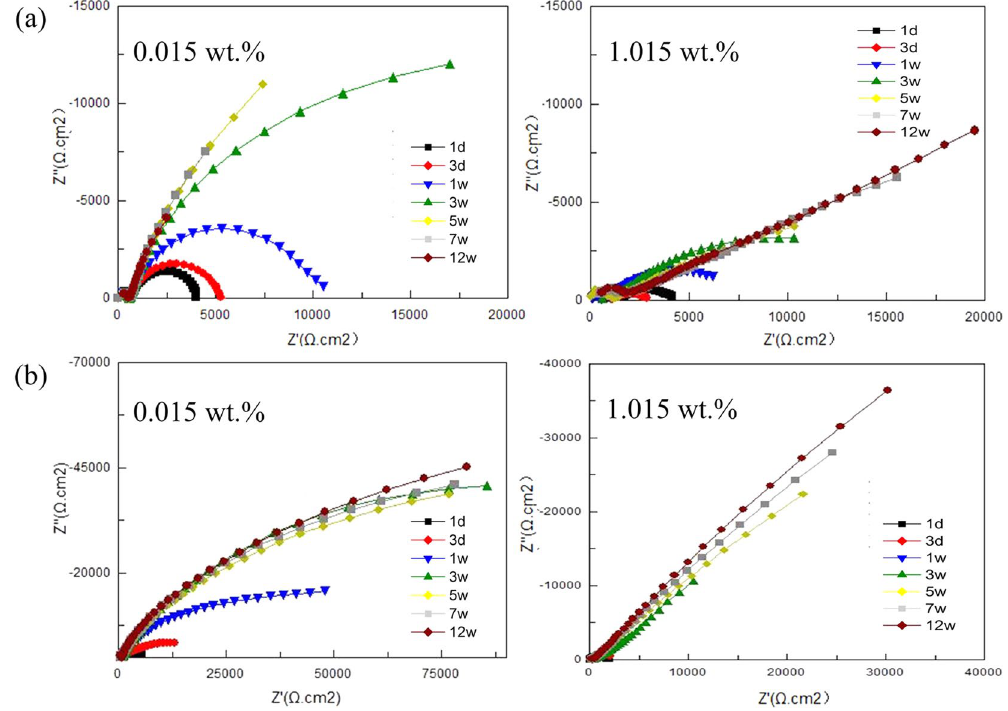
Figure 10. Nyquist plots of ductile iron ( a ) (the first row) and carbon steel ( b ) (the second row) in soils (0.015 wt.% and 1.015 wt.% of chloride contents) after different exposure